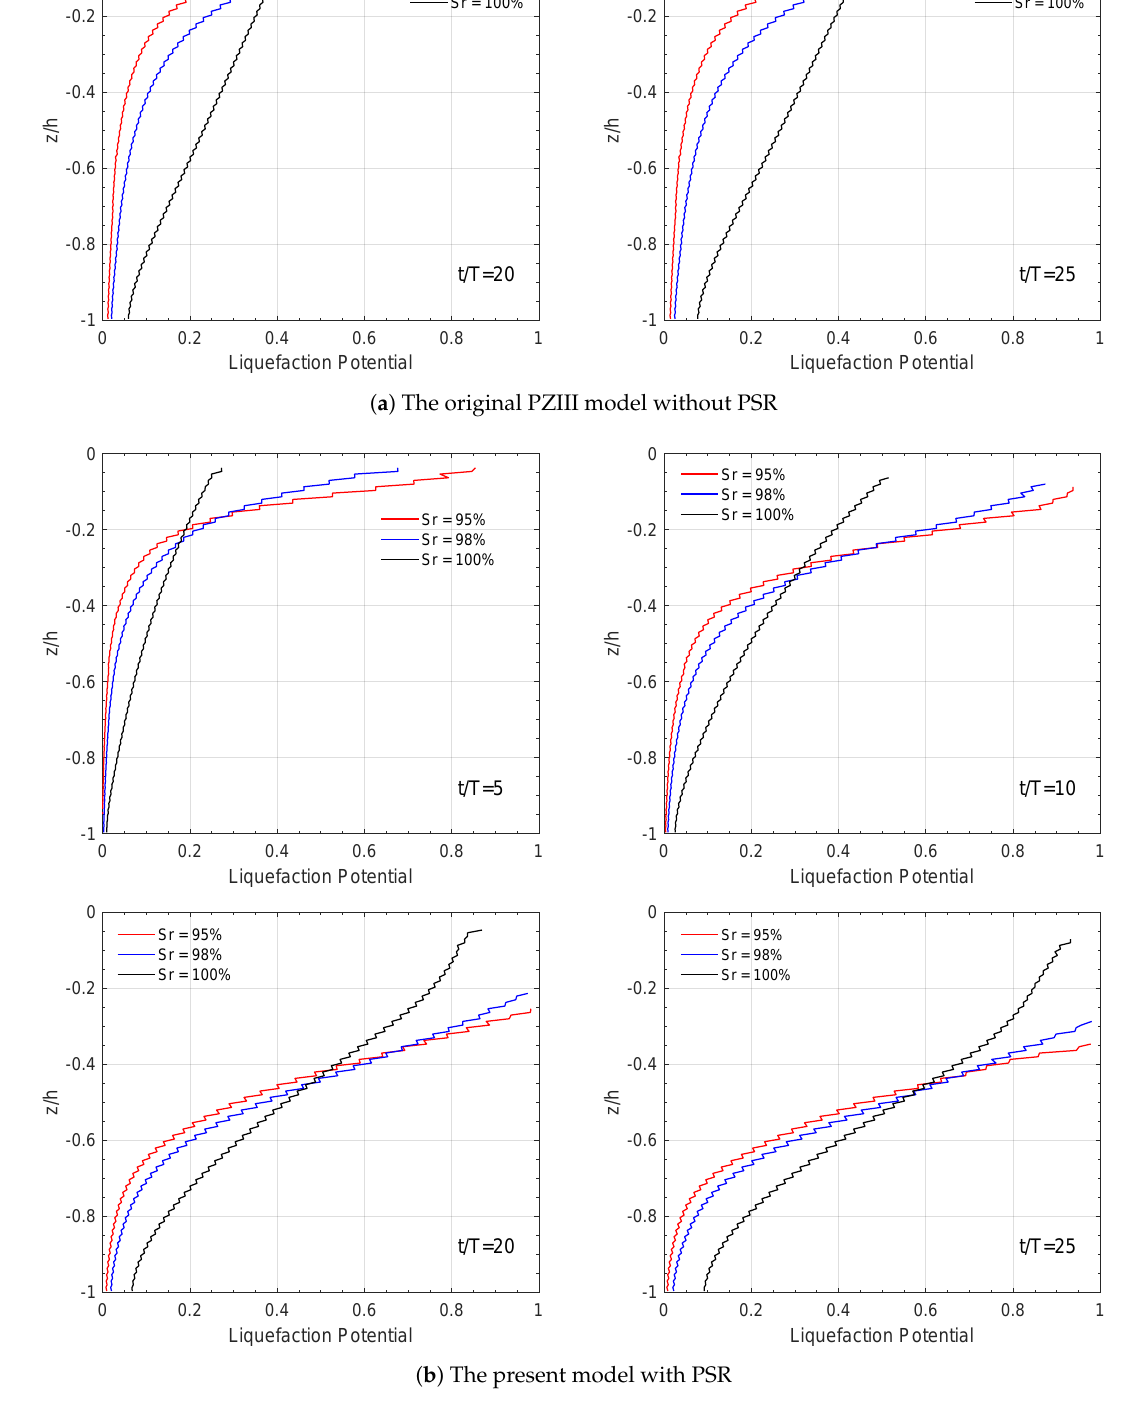
Figure 14. Effect of the degree of Sr considering PSR on the vertical distribution of liquefaction potential on z = − 5 m at four typical time points. ( a ) The original PZIII model without PSR and ( b ) the present model with